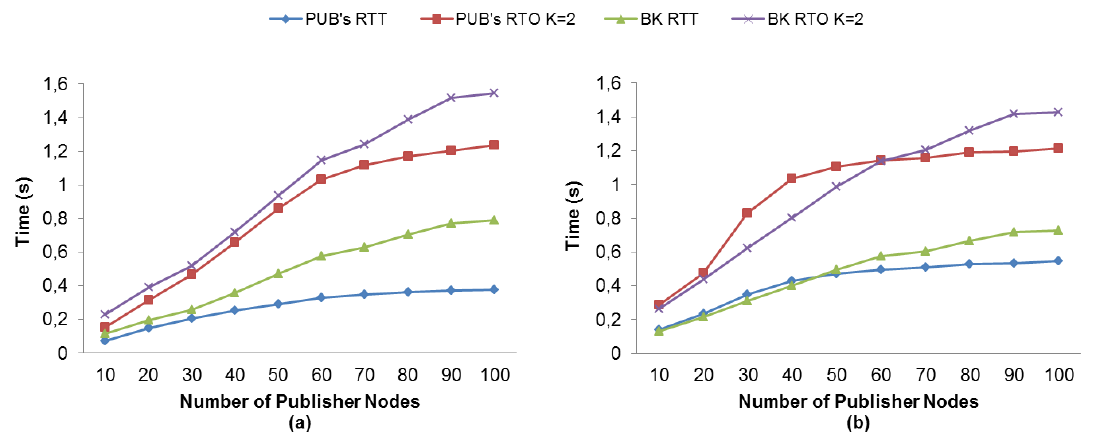
Figure 9. RTT and RTO comparisons for CoAP with our method without ( a ) and with ( b ) the use of MAC